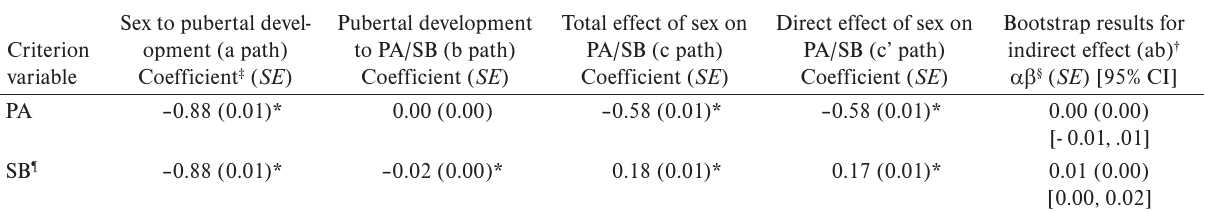
Table 2 Total, direct, and indirect effects of the relationships between (1) sex, pubertal development, and physical activity (PA), and (2) sex, pubertal development, and sedentary behavior (SB) – Korea Youth Risk Behavior Web-based Survey, 2012 (n = 53,347)